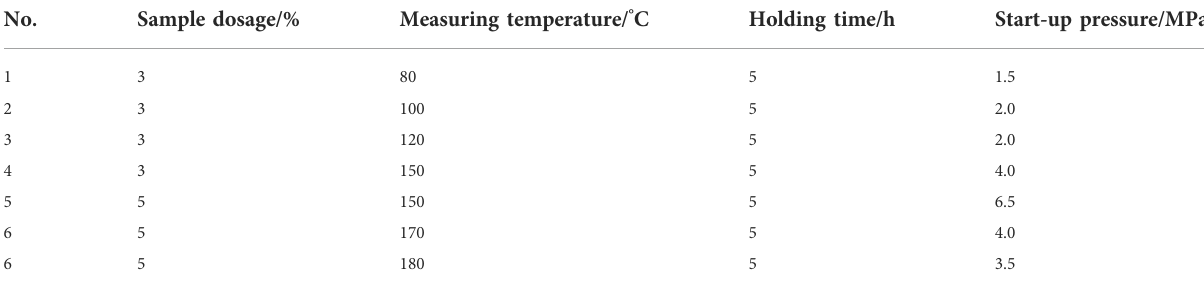
TABLE 6 ZND-6 start-up